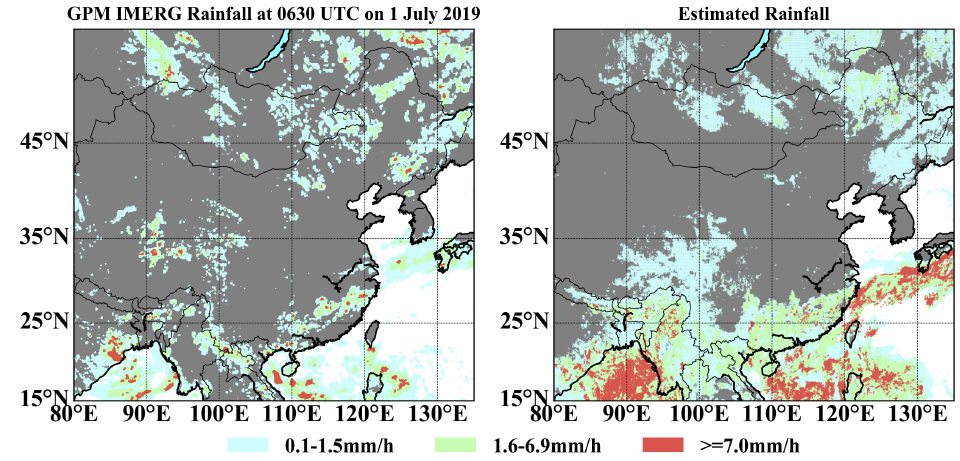
Figure 18. Comparisons of the rainfall retrieval integrated model between the GPM ( left ) and RF model ( right ) at 0630 UTC 1 July